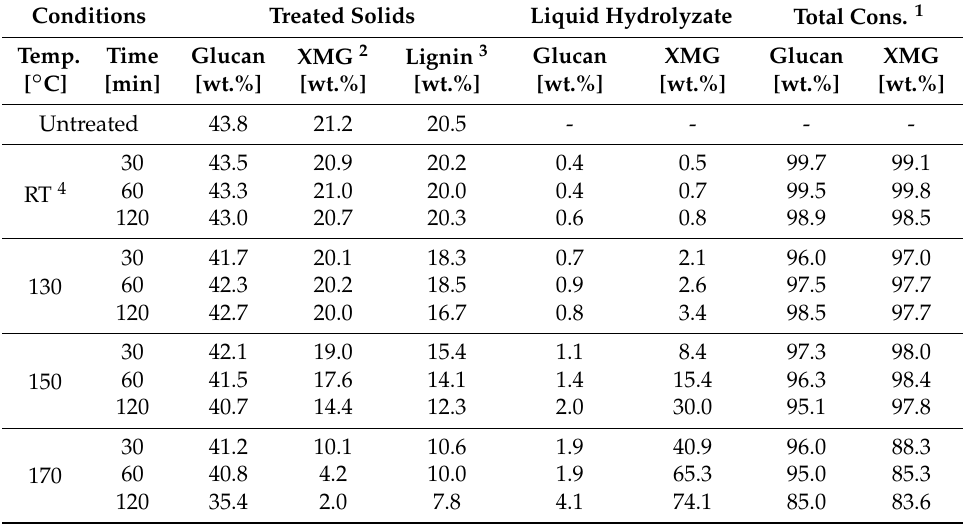
Table 1. Effects of reaction temperature and time on chemical compositions of treated solids and liquid hydrolyzate. Conditions Treated Solids Liquid Hydrolyzate Total Cons. 1